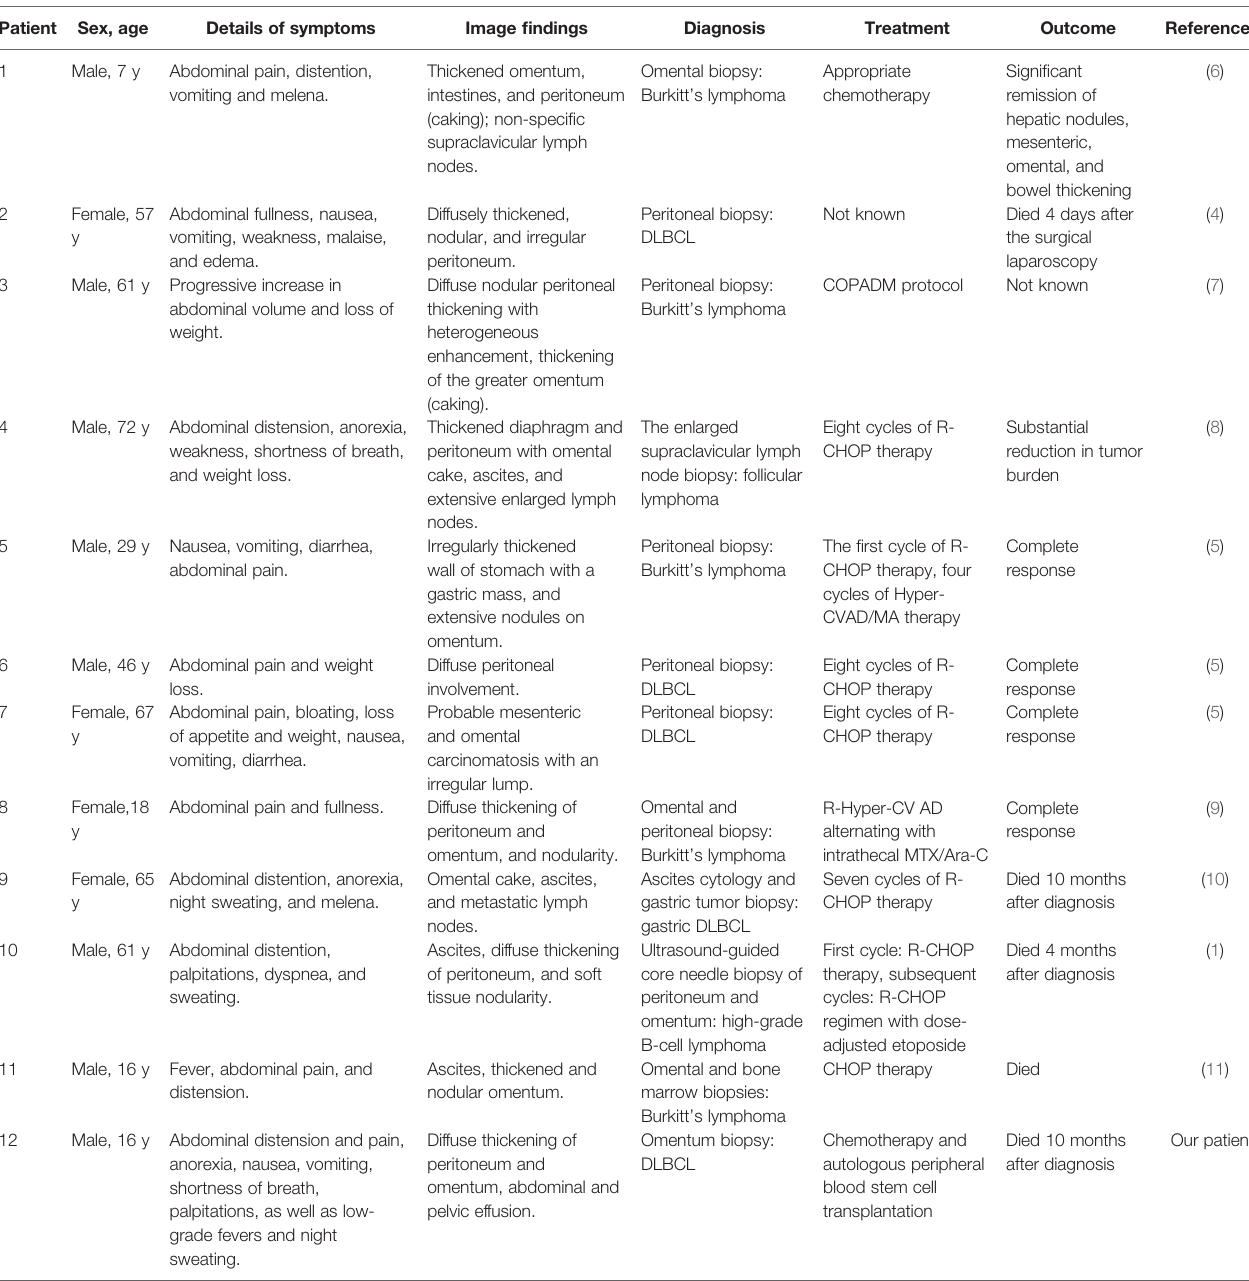
TABLE 1 | Literature review of peritoneal